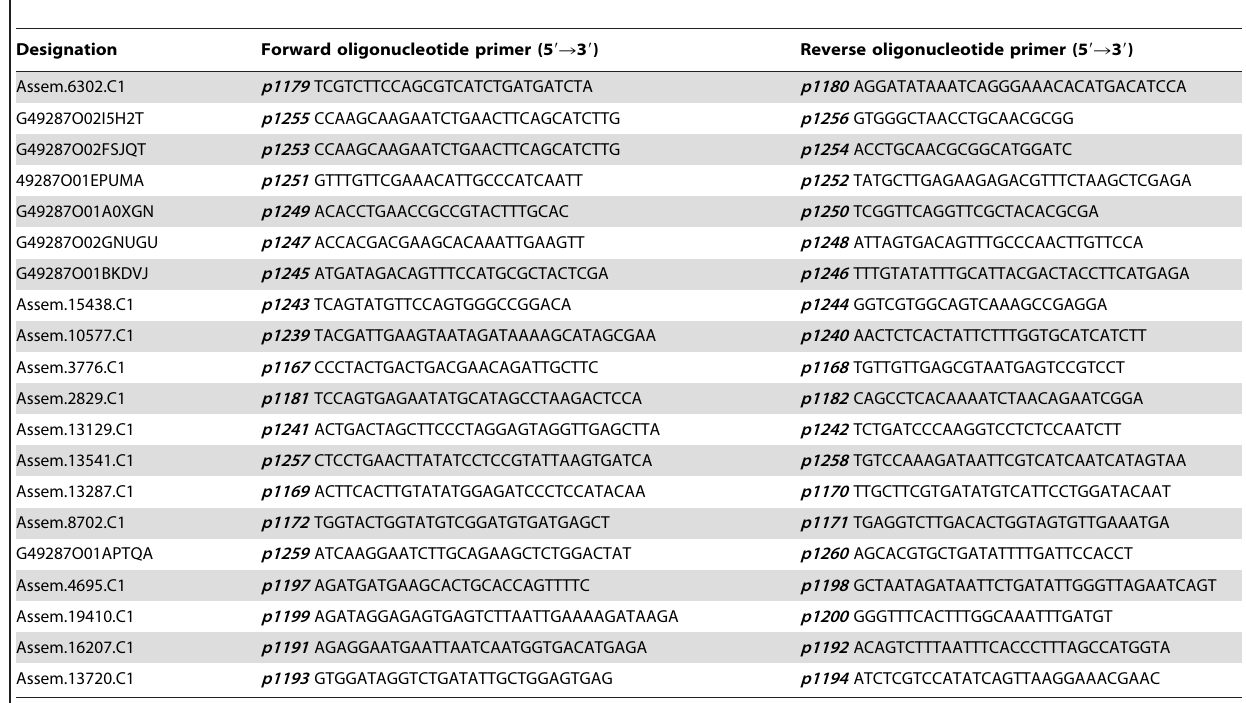
Table 1. Oligonucleotide primers designed to each corresponding N. pubens sequence with viral identity.